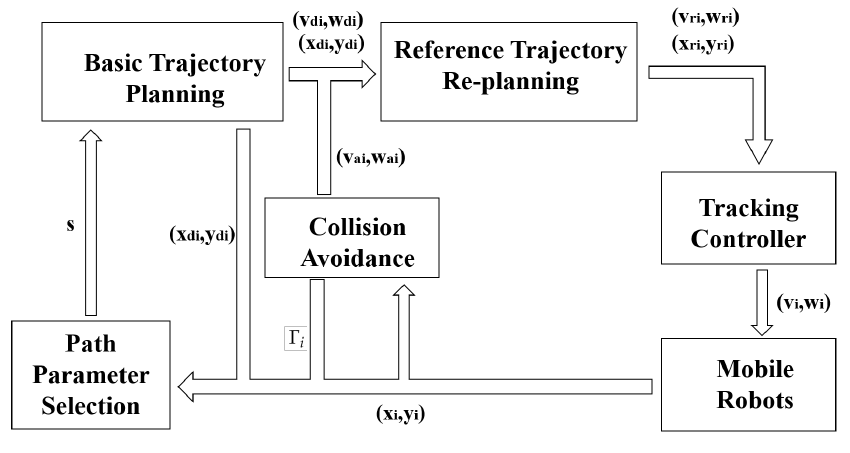
Figure 2. Formation control